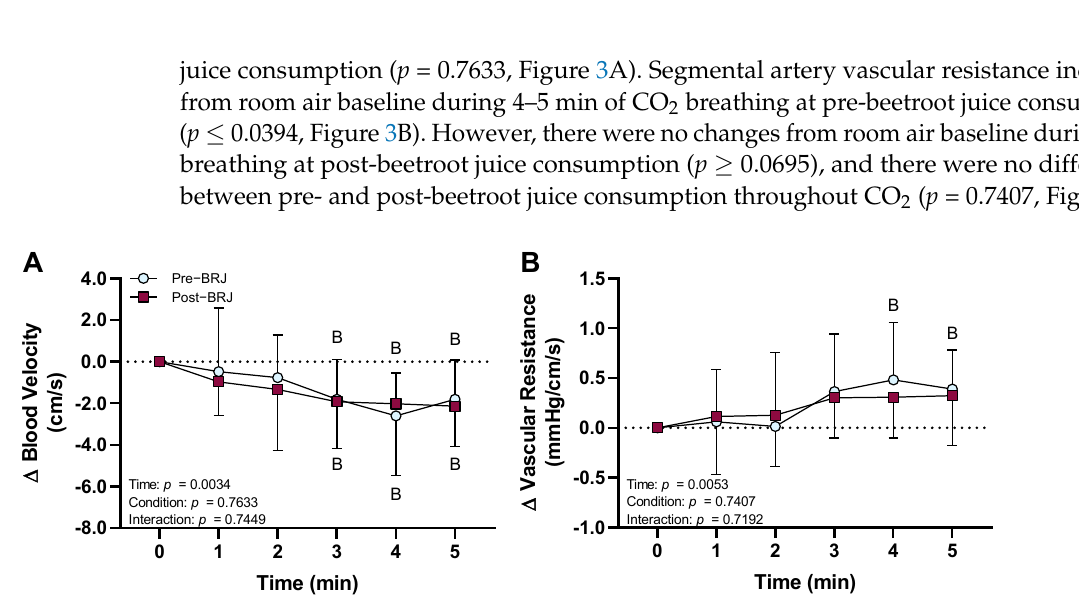
Figure 3. Effect of beetroot juice (BRJ, condition) at three hours post-consumption on blood velocity and vascular resistance in the segmental artery during CO 2 breathing (time). Data are presented as the means ± SD as the change from room air baseline (0 min). Data were analyzed using a two-way repeated-measures ANOVA with post hoc Dunnett’s tests to com- pare changes during CO 2 from room air baseline and post hoc Sidak’s tests to compare differences between pre- and post- beetroot juice consumption during CO 2 breathing. ( A ) segmental artery blood velocity; ( B ) segmental artery vascular re- sistance. n = 14 (7 females and 7 males). B different from room air baseline ( p ≤ 0.0394).